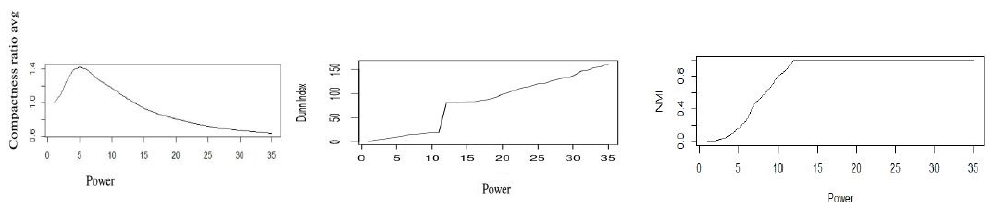
Figure 4. Compactness, Donn index and Normalized mutual information. Spiral dataset.